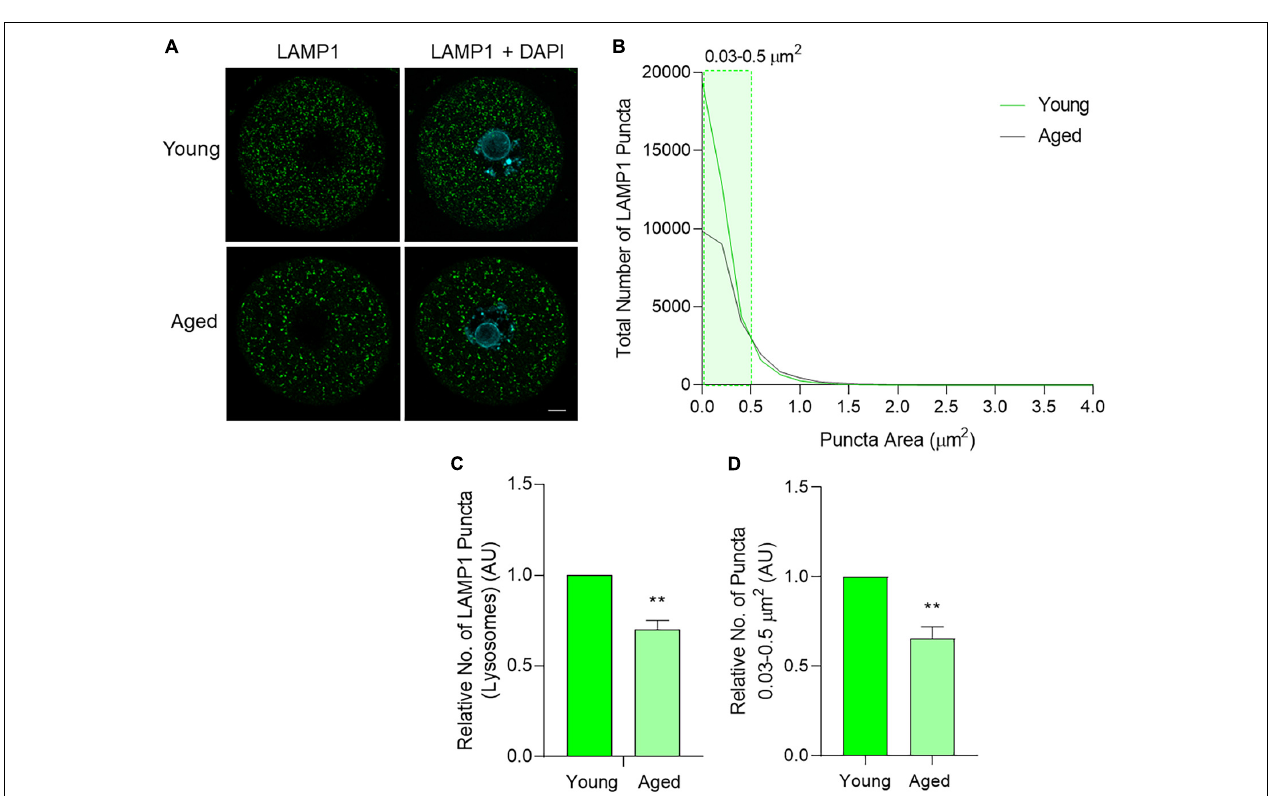
FIGURE 8 | LAMP1 protein localization and puncta distribution in young and aged mouse oocytes. Oocytes from young (4–6 weeks old) and aged (12–14 months old) mice were fixed prior to labeling with anti-LAMP1 antibodies (green), nuclear counterstaining with DAPI (cyan), confocal imaging (60 × objective), and puncta analysis. (A) Representative images illustrate the punctate cytoplasmic localization of LAMP1 in young and aged oocytes. Scale bar = 10 µ m. (B) Images were assessed for the number and size of LAMP1 labeled puncta and these data were used to graph the size distribution of puncta in populations of young (green line) and aged (gray line) oocytes. The puncta size group that differed significantly in abundance between young and aged oocytes is highlighted in green shading. (C) Comparison of the total number of LAMP1 labeled puncta per oocyte in young and aged oocytes (normalized to young). (D) Comparison of LAMP1 labeled puncta sized 0.03–0.5 µ m 2 pertaining to lysosome area documented in literature (Ponsford et al., 2020; Trivedi et al., 2020) in young and aged oocytes (normalized to young). N = 4, ** P ≤ 0.01.